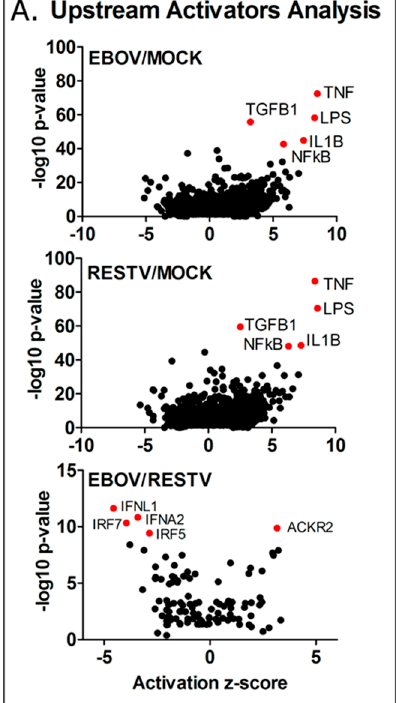
Figure 5. Upstream regulator analysis was performed using canonical pathway analysis data. Transcriptswerealignedtocanonicalpathwaysandtheircumulativeincreasingordecreasingabundance measurements compared with mock infection, or comparing EBOV to RESTV directly, were used to calculate pathway activation score (z-score). Activation scores range from decreasing activity ( − 10) to increasing activity ( + 10) based on predictive calculations. For EBOV / RESTV comparison, the range is smaller (between − 5 and + 5) due to reduced variation in pathway activity. Only the top five pathways either increasing or decreasing are indicated based on both z-score and − log10 p -value. As 72 h represented the most divergent time point comparing EBOV with RESTV, only data collected from this time point were used in these calculations. TNF, LPS (TLR4 ligand), TGFB1, IL1B, and NF κ B are shown as highly active upstream regulators in both EBOV and RESTV infection compared with mock infection. Comparing Makona (EBOV) directly with RESTV shows that IFNL1, IFNA2, IRF7, IRF5, and ACKR2 are significant upstream regulators. The direct comparative analysis shows significant though reduced − log10 p -values due to reduced numbers of